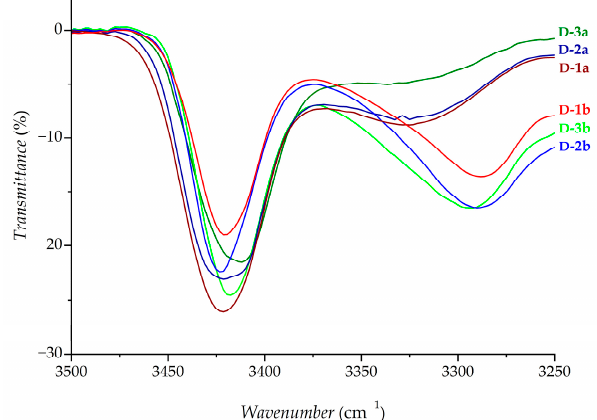
Figure 3. The NH region of the FTIR spectra of D - 1a – 3a and D - 1b – 3b